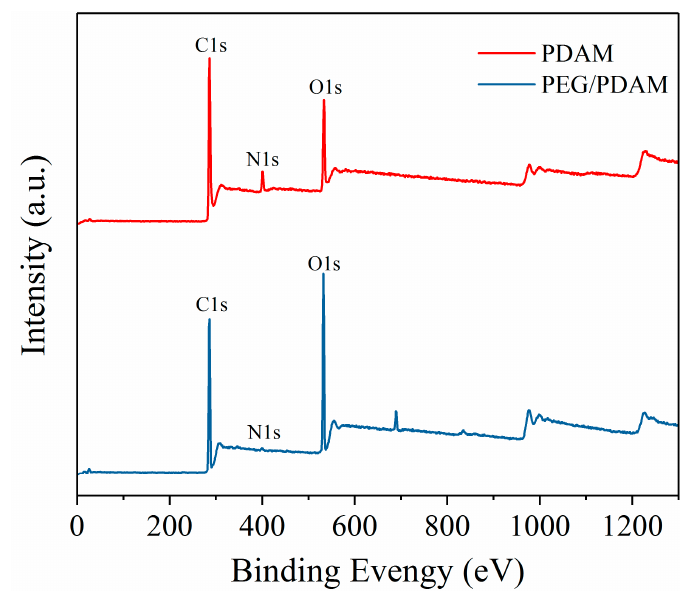
Figure 13. XPS survey of the PDAMs and PEG / PDAM-3.